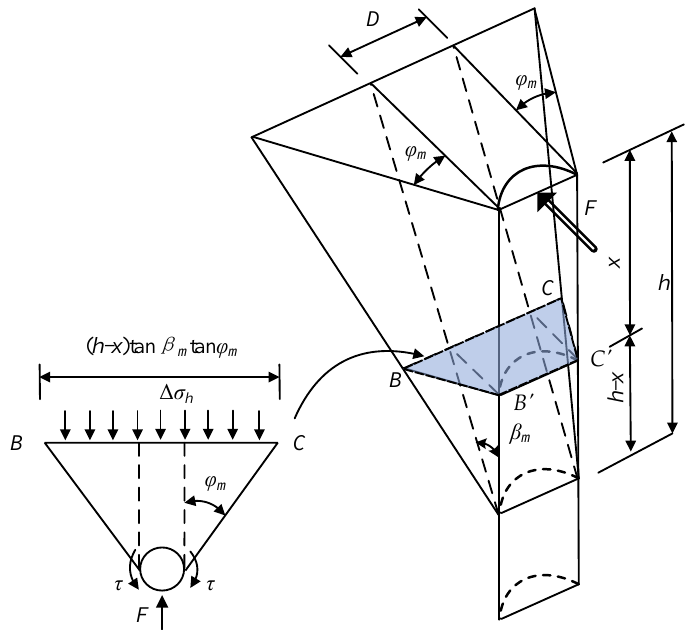
Figure 3. Basic strain wedge in uniform soil (Modified from Ashour et al. [21]).